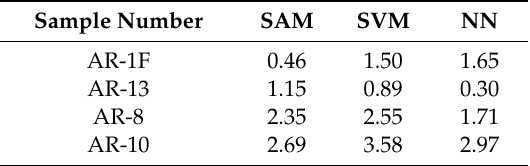
Table 3. Error distance for each sample .